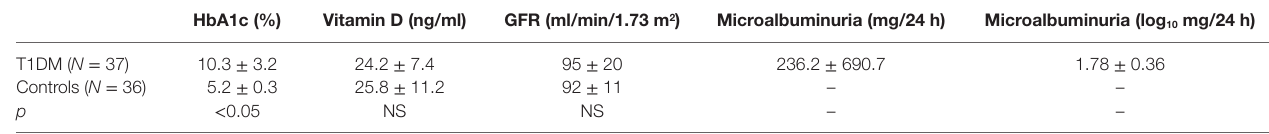
Table 2 | laboratory characteristics of T1DM and controls.